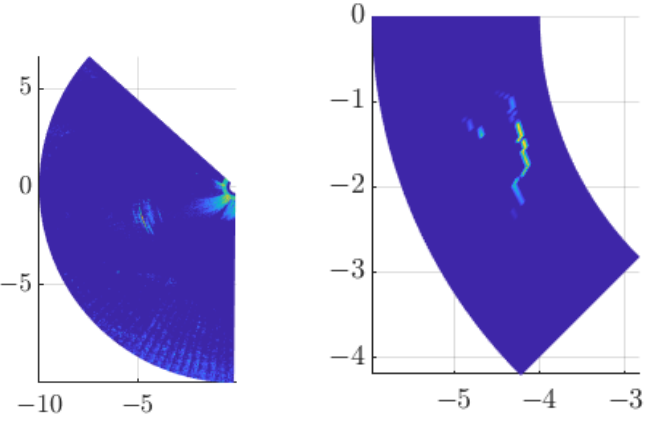
Figure 9. An example of image processing for sonar imagery measured at Lake Wysockie near Gda´nsk (Poland) for the cylinder-shaped object. In measurements performed in a real environment, the impact of environmental instability on the final result of image processing can be noticed [own